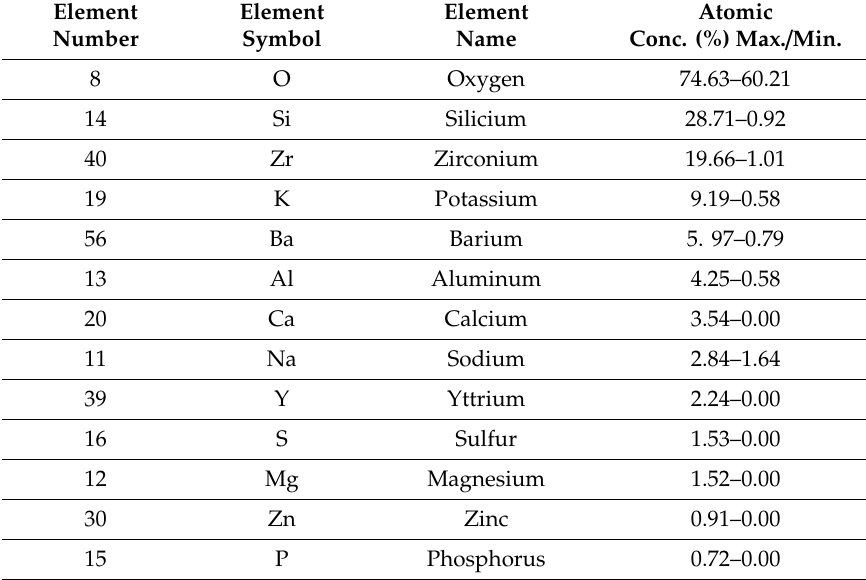
Table 3. Chemical analysis of particulate residues on zirconia/Ti-Base samples before ultrasonic cleaning by element and maximum/minimum atomic concentration.